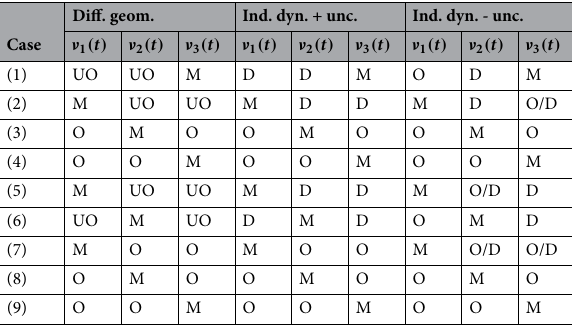
Table 4. Overview of the results of the observability/detectability